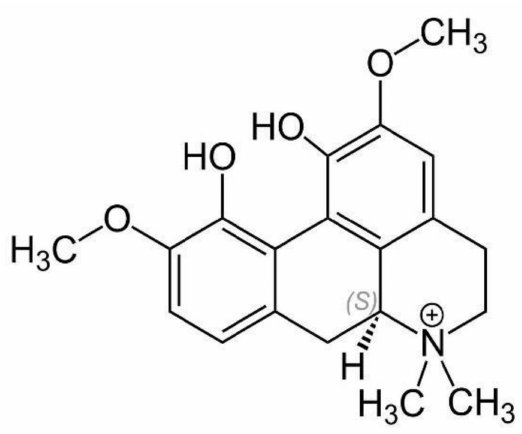
Figure 7. Chemical structure of